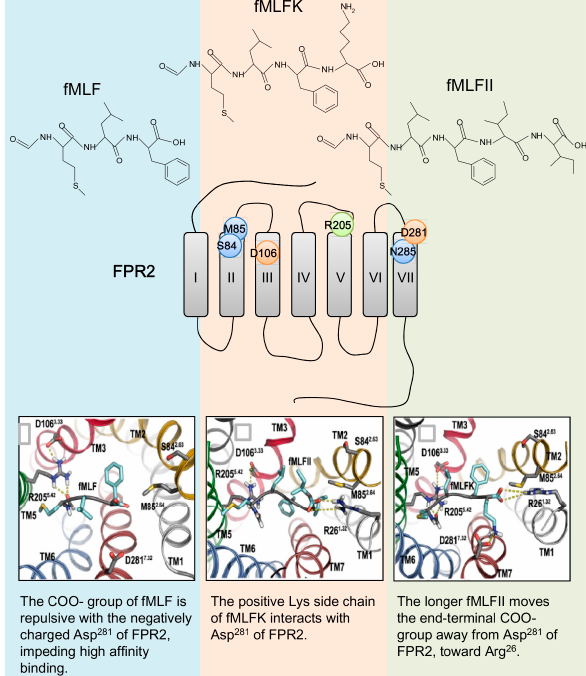
Figure 3. CXCR4-based homology models of FPR2 (middle) in complex with three formyl peptides of different composition (top). The lower panel show the molecular interaction of FPR2 residues with the side chains of fMLF (left), fMLFK (middle) and fMLFII (right) in a computational model of FPR2. The lower panels were adapted from [96] with permission.